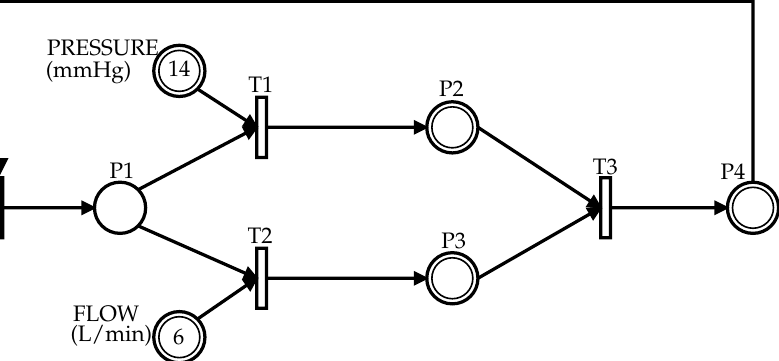
Figure 5. Example of a HPN obtained from BN. In this case, arterial pressure is considered to be high when above 14 mmHg and blood flow is high when above 6